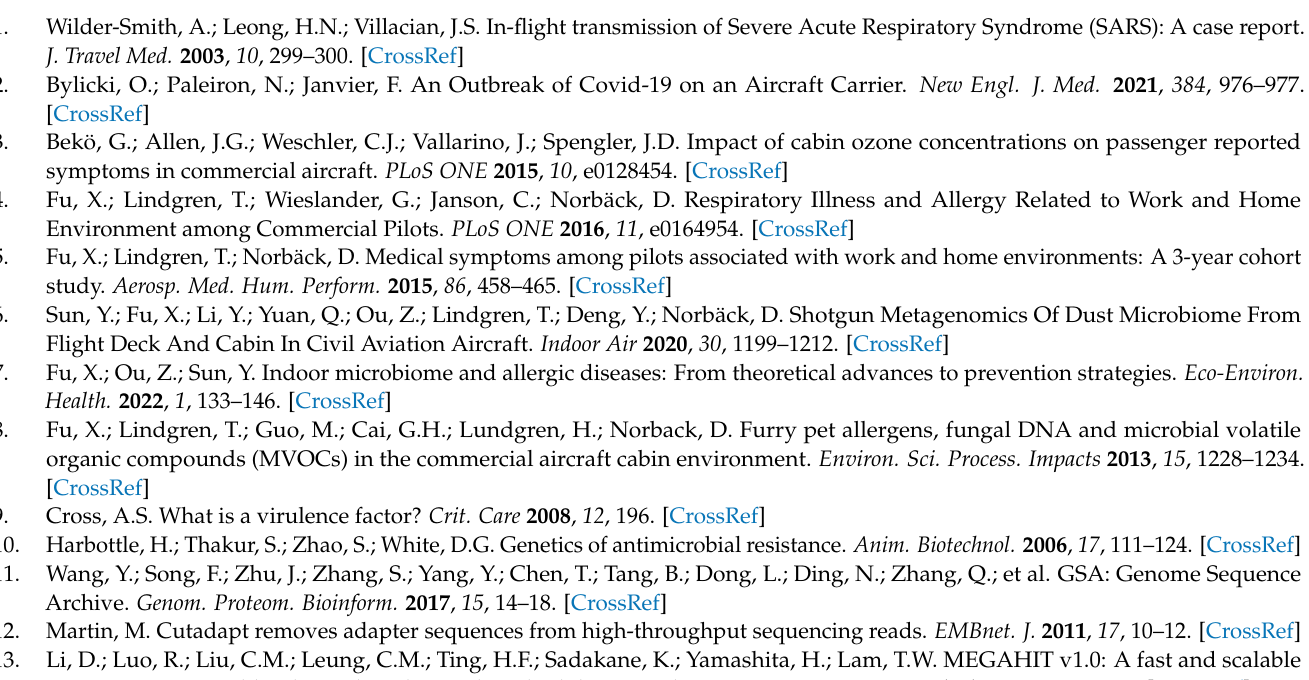
LSC; Table S2: Enriched antibiotic resistance genes in TSC and LSC; Table S3: Potential risk chemicals in TSC and LSC. Table S4. Potential protective metabolites in TSC and LSC. Flavonoids, isoflavonoids, indoles, and keto acids are characterized as protective metabolites for